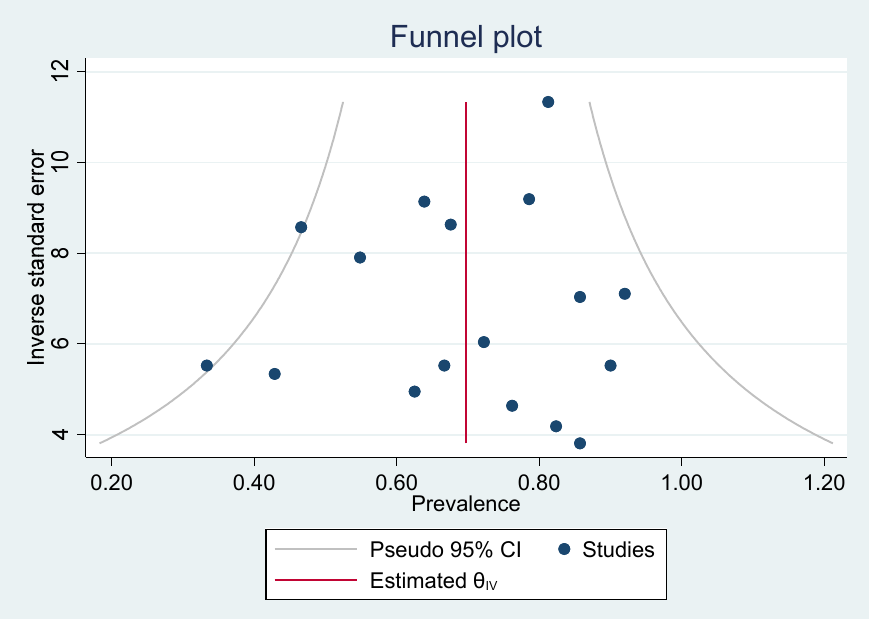
Figure 3. Funnel plot for publication bias evaluation.